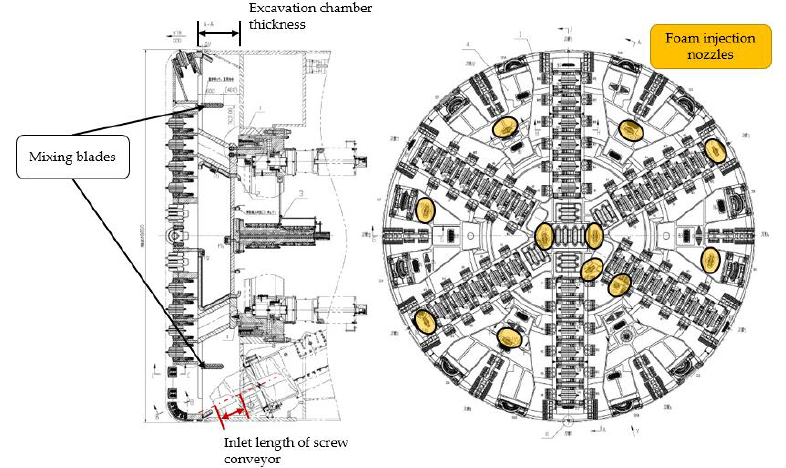
Figure 1. Illustration of mechanical components affecting mud cake formation risk in DZ187 shield machine.